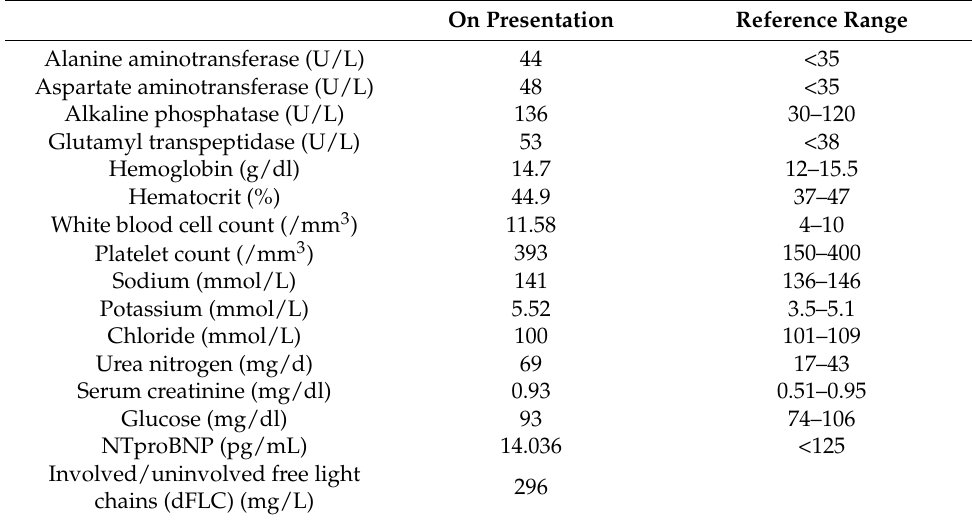
Table 1. Laboratory